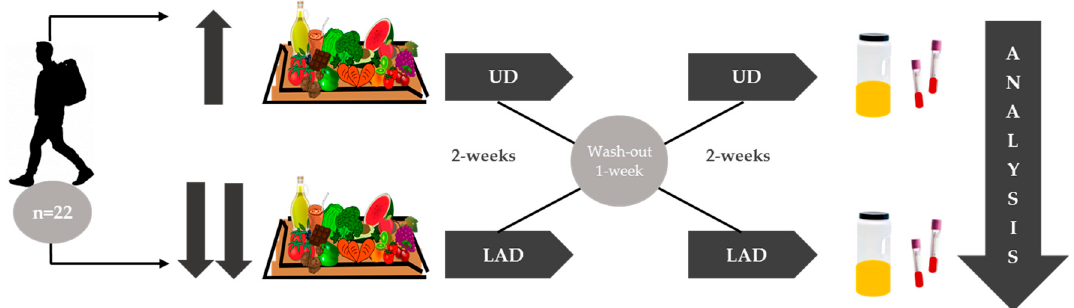
Figure 2. General scheme of the crossover trial with two intervention periods.